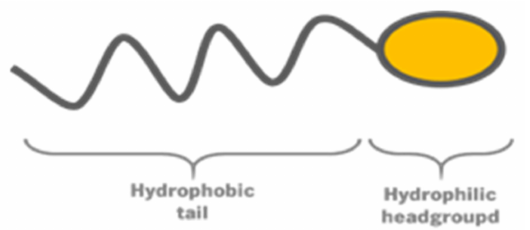
Figure 1. Schematic representation of a polar lipid molecule. Polar lipidic molecules present two do- mains: a hydrophilic headgroup (polar) and a hydrophobic tail (apolar).